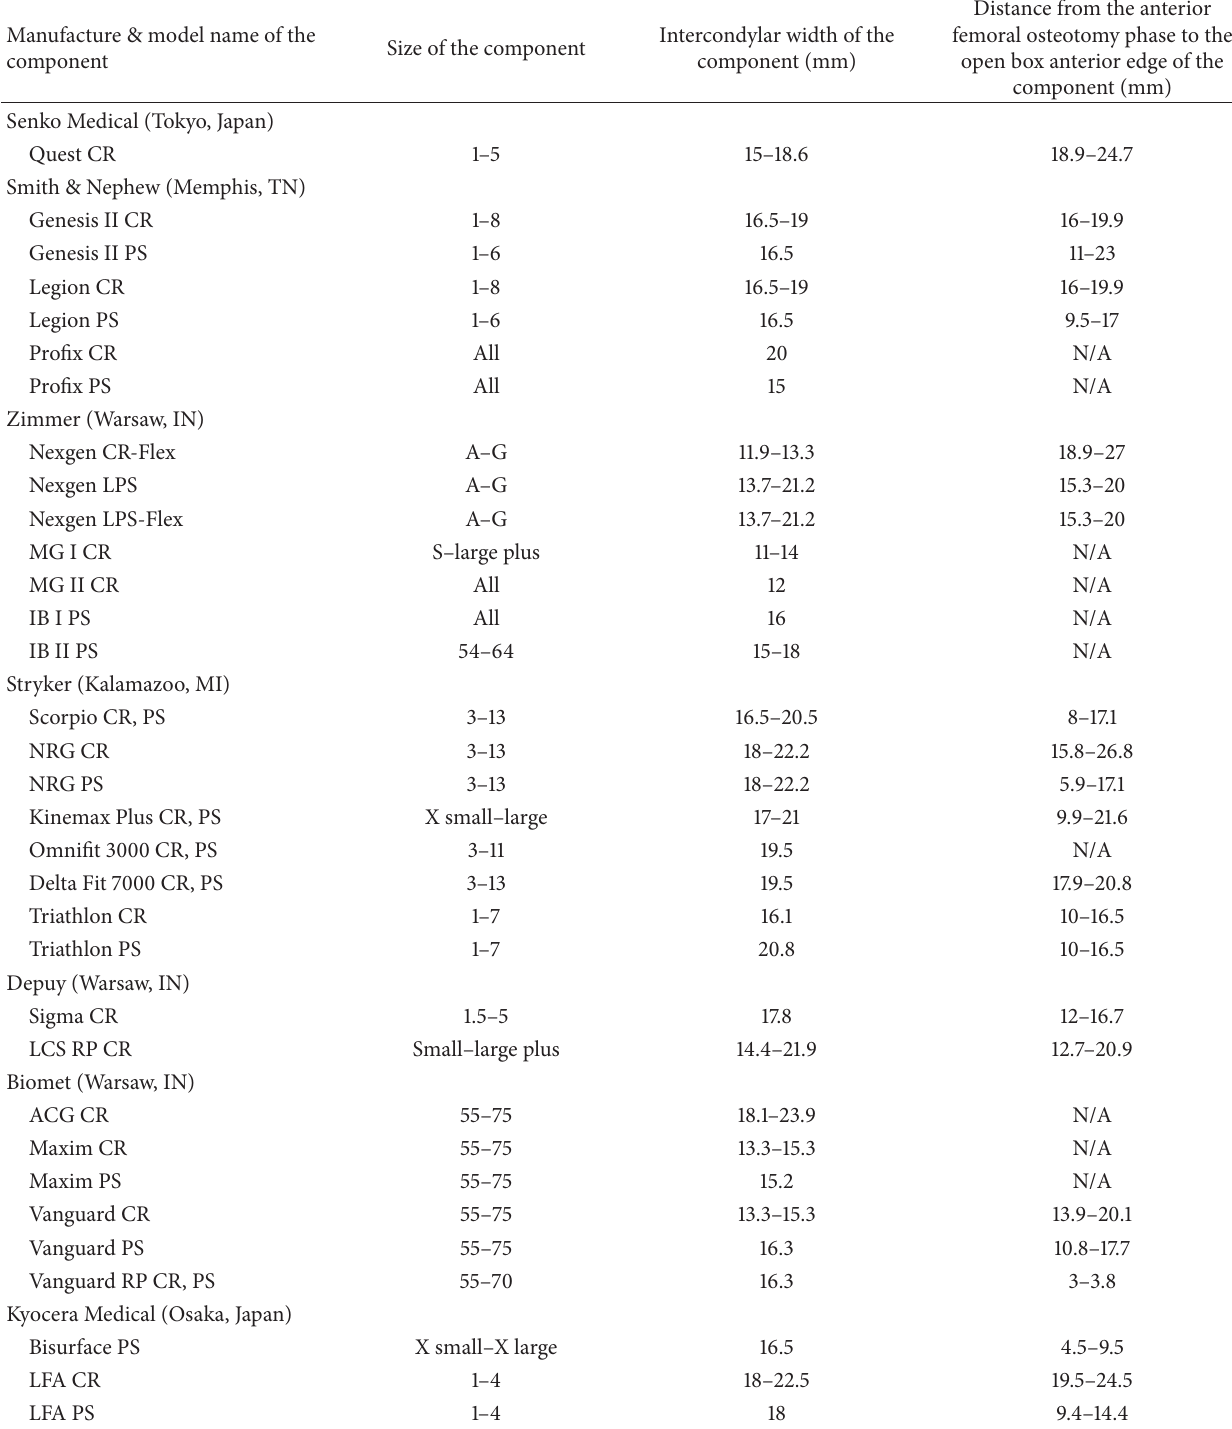
Table 1: Intercondylar notch designs of the inserted TKAs and their compatibility with supracondylar nails. All these dimensions were officially provided by the